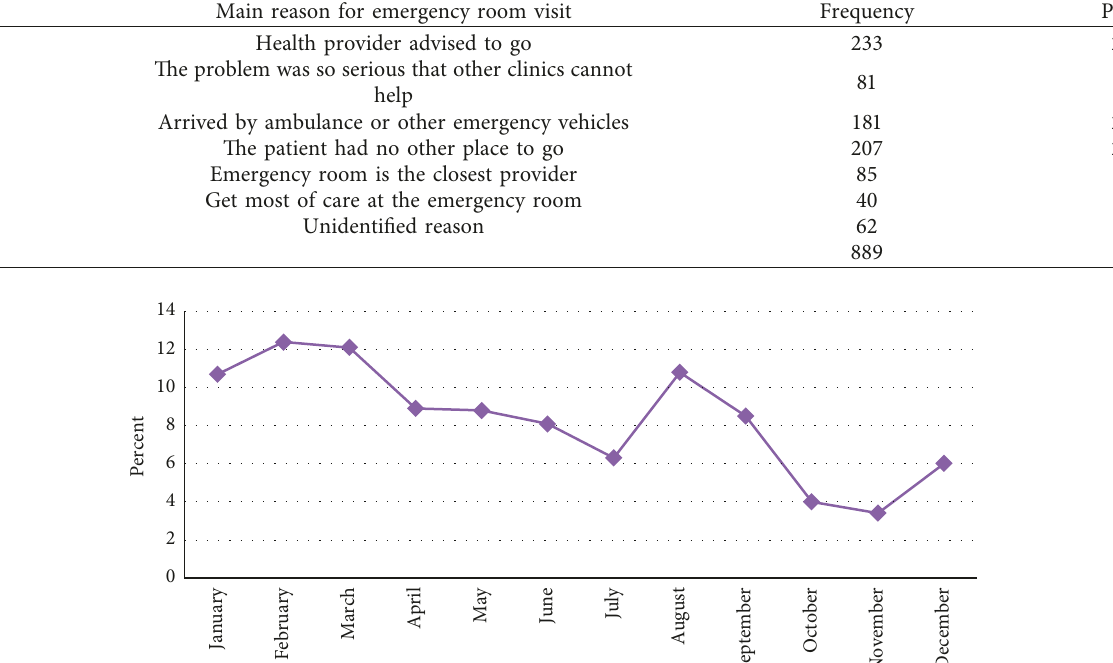
Table 3: Respondents’ main reason for emergency room visit in Nekemte, western Ethiopia, 2017.